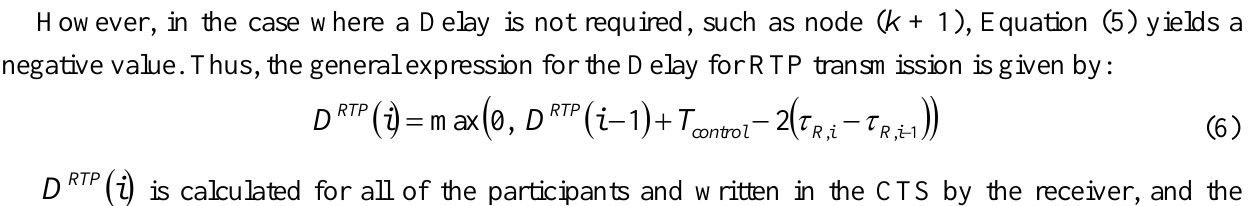
Figure 7. Determination of the Delay for RTP